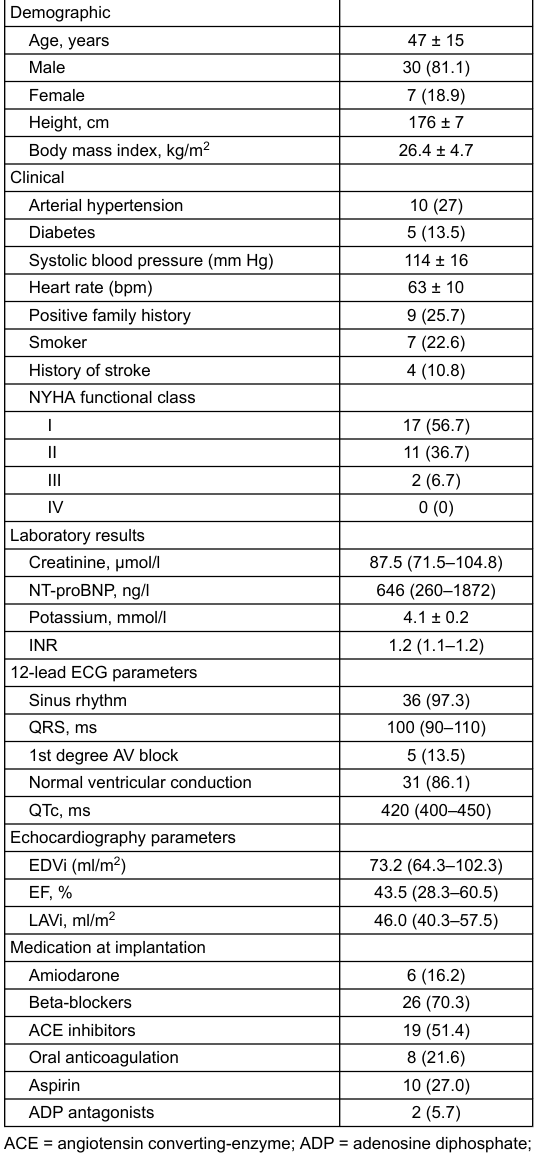
Table 1: Baseline characteristics of patients undergoing S-ICD implan-